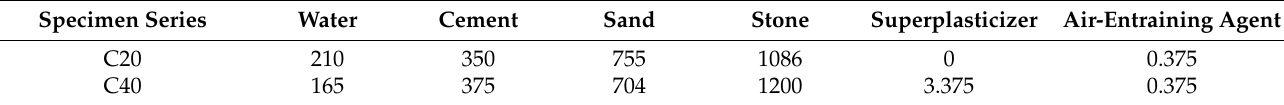
Table 1. Mix proportion of concrete (kg/m 3 ).